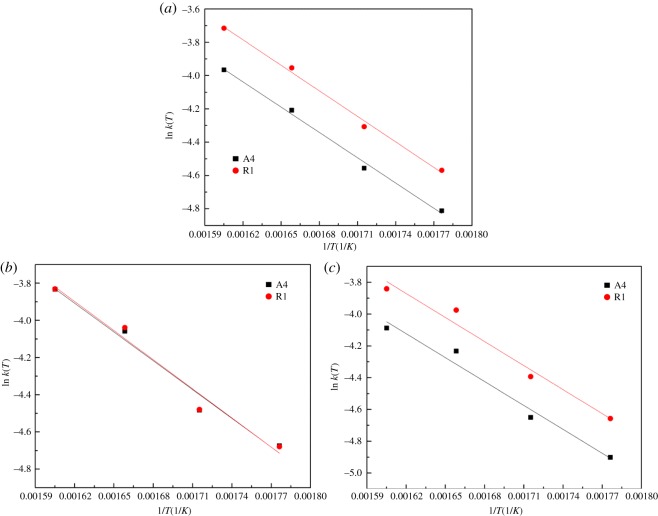
The plots of ln k(T) versus 1/T for different mechanism functions for the (a) YBaCo4O7+δ, (b) Y0.95Ti0.05BaCo4O7+δ and (c) Y0.5Dy0.5BaCo4O7+δ samples.